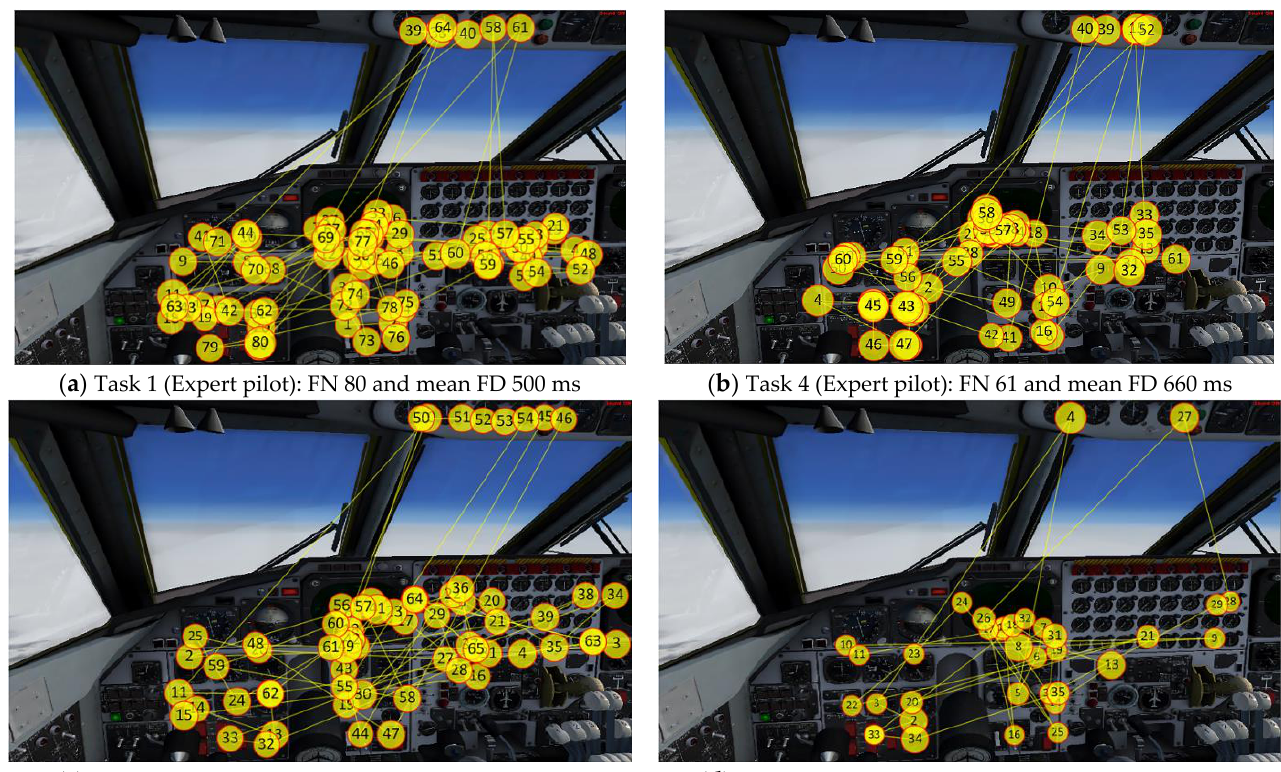
Figure 5. Examples of visual scanpaths of an expert and a novice pilot: The yellow circles represent the eye fixations where the numbers represent its index. The yellow lines represent the saccades. The size of the eye fixation circles have been kept at a fixed size for visual clarity. In addition, only 40 s of data are provided for each sample. FN is the eye fixation number, and FD is the eye fixation duration.